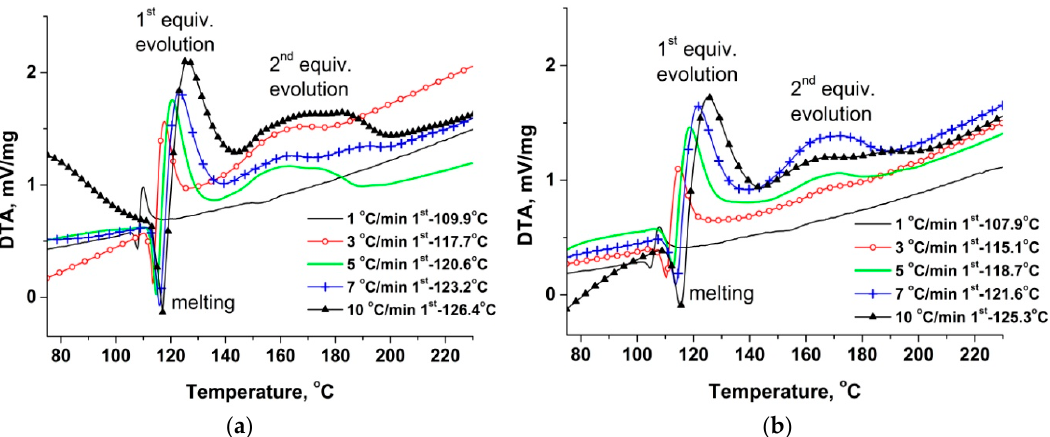
Figure 5. DTA curves for 93% ( a ) and 79% ( b ) pure samples of NH 3 BH 3 obtained at the rates of heating from 1 to 10 °C/min. Also shown are the temperatures of the maxima corresponding to the first stage of ammonia borane dehydrogenation (1).